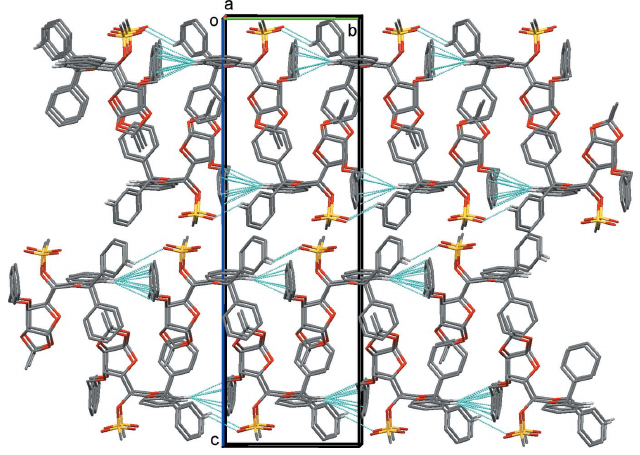
Figure 5 A view along the b axis of the crystal packing of compound 4 . The C— H (cid:2)(cid:2)(cid:2) O and C—H (cid:2)(cid:2)(cid:2) (cid:2) interactions (see Table 2) are shown as dashed lines. For clarity, only the H atoms involved in these interactions have been included. The channels in the crystal structure are shown in brown ( Mercury ; Macrae et al. ,